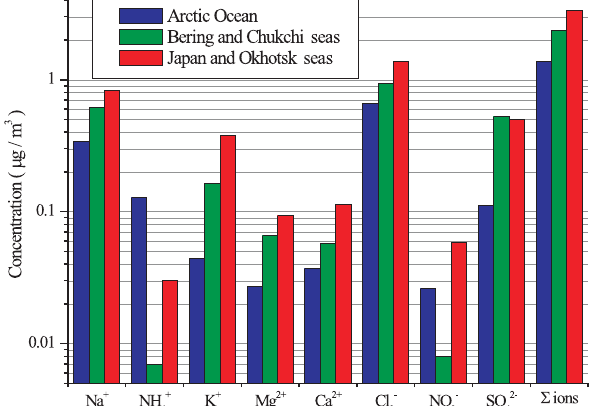
Figure 12. Average ion content in aerosol over Arctic and Far East